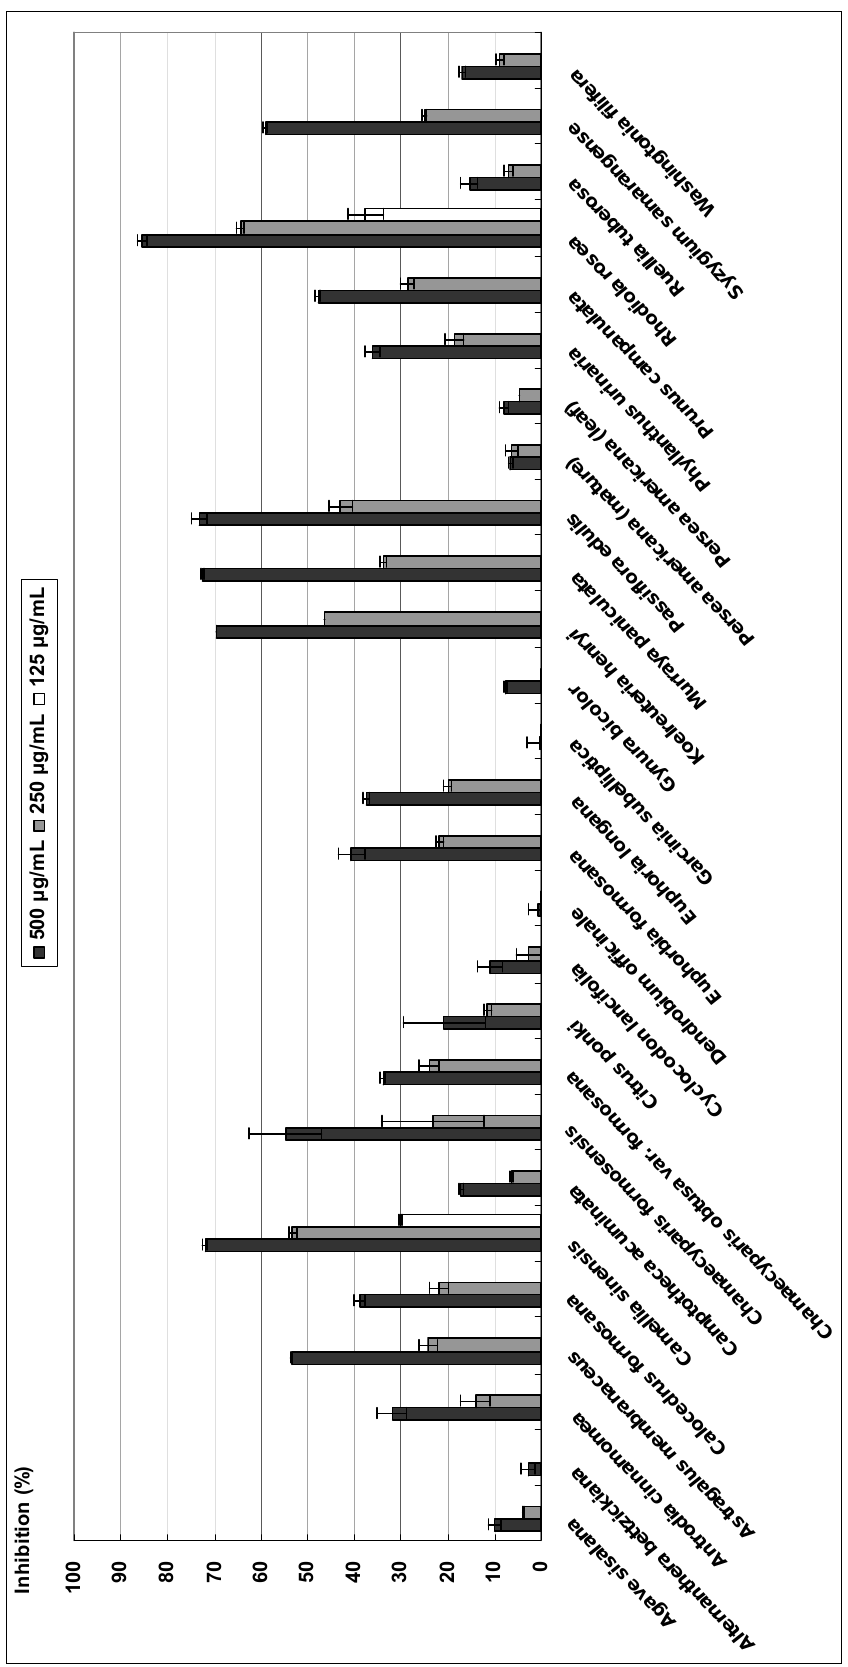
Figure 2. Inhibitory effect of 27 plant acetone extracts on tyrosinase